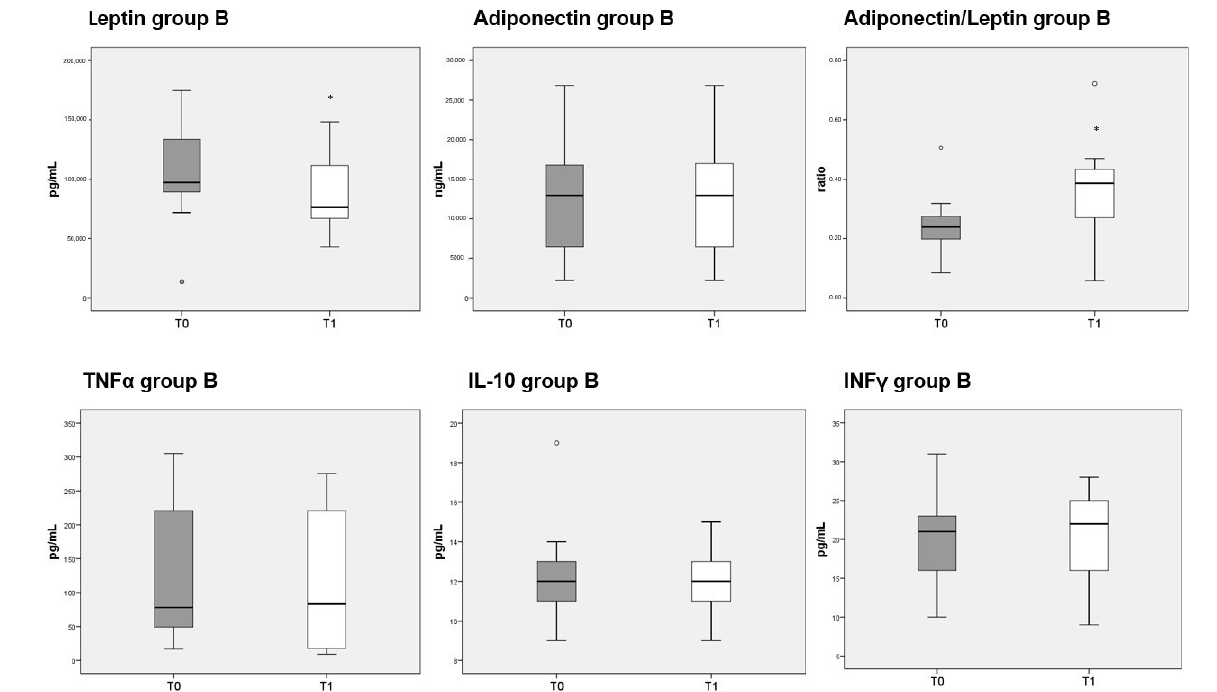
Figure 6. Box plots show the median and interquartile range of adipokines and cytokines measured in sera of patients belonging to group B. p -values derived from Wilcoxon matched-pairs signed rank test; * p < 0.05, T1 vs.